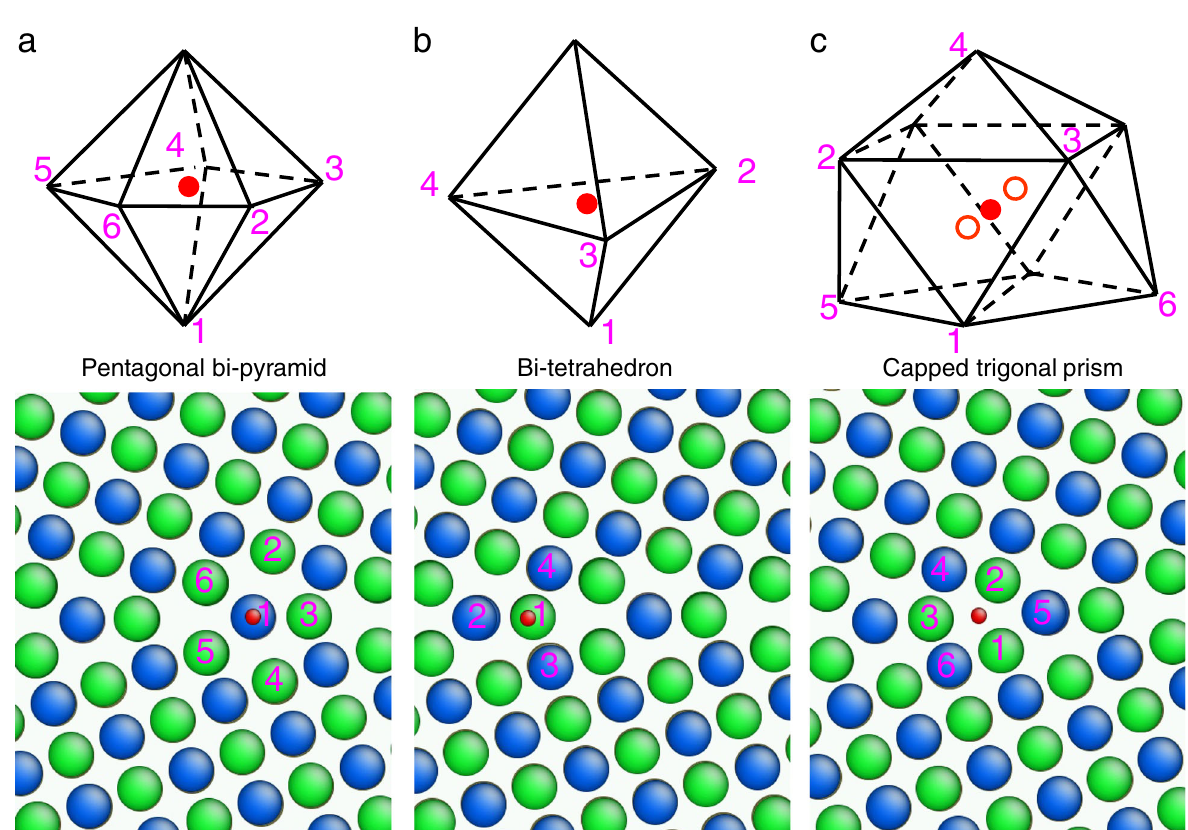
Fig. 2 H adsorption at different interstitial sites of a ∑ 5(310)[001] GB. a Schematic of the H adsorption site ( red circle ) in a pentagonal bi- pyramid packing unit ( above ) and corresponding atomic structure ( below ). b Same as a except for a bi-tetrahedron packing unit. c Same as a except for a capped trigonal prism packing unit. To facilitate the visualization of deltahedral packing units, the vertices and corresponding atoms of the same kind of deltahedral unit are numbered in the schematics above and the atomic structures below, respectively. Green and blue atoms belongs to adjacent (001)